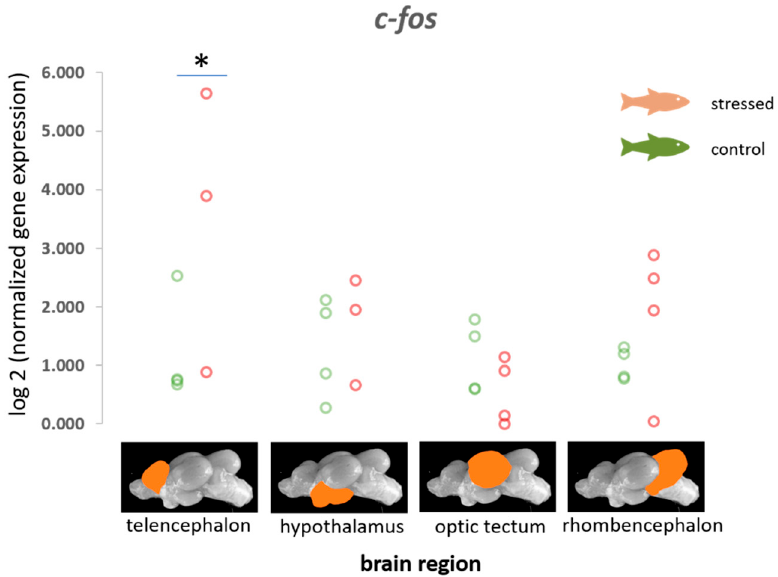
Figure 1. Gene expression profile of the immediate early gene c-fos in each of the four brain parts in the control fish and fish 30 min after the air exposure with 95% confidence intervals of 0.72 to 2.1 for the control and 2.1 to 18.5 for the stressed fish for the values for the telencephalon derived from the adjusted bootstrap percentile (BCa) method; n = 4 per treatment, * = significance according to the Man–Whitney U tests, p < 0.05. Table 1. Probabilities for potential group differences between the control animals and the distressed fish ( n = 4 each) in the different brain parts, the table shows for each of the genes the point estimator displayed in bold, the SEM in brackets, and the credibility interval and the posteriori p value in the second row.